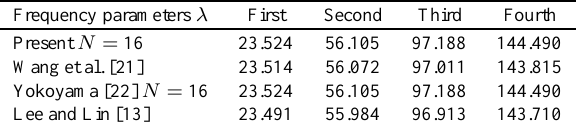
Table 4 Comparison of frequency parameters for rotating uniform